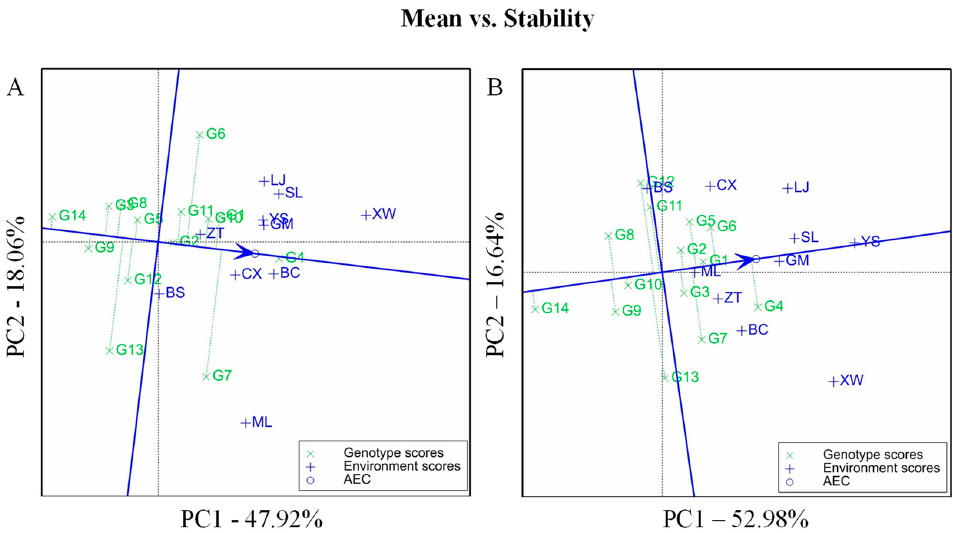
Figure 3. GGE biplot showing mean and stability of 14 maize hybrids for yield across 10 locations. Genotypes on the extreme right are highest-yielding; those having smaller projection on the ordinate are relatively stable: ( A ) GGE biplot in 2020; ( B ) GGE biplot in 2021. See genotype and environment codes in Tables 1 and 2, respectively.